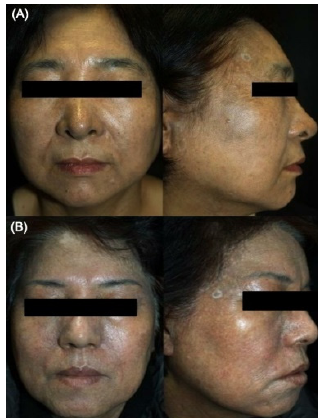
Figure 1. Clinical photographs of two representative patients with Riehl’s melanosis. ( A ) A 57-year-old female showing diffuse reticulated brown to slate-gray pigmentation on the face. ( B ) A 63-year-old female showing reticulated macules of brownish to grayish dyspigmentation on the face and neck.